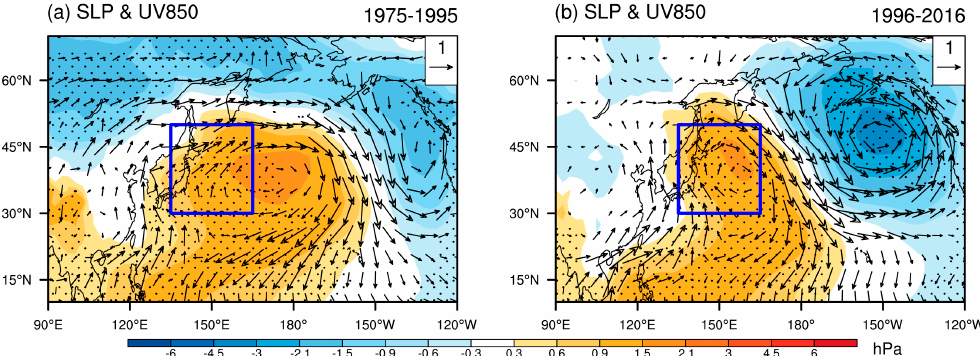
Figure 5. ( a ) The wintertime SLP (shading) and 850 hPa winds (vectors) regressed on the AL-independent Niño-3 index over the East Asia–North Pacific region during 1975–1995. ( b ) As in ( a ), but for 1996–2016. Dots indicate the 90% confidence level based on a two-tailed Student’s t -test. Vectors exceeding 0.1 m/s are shown. The blue boxes in ( a , b ) indicate the region to define the KACI index.